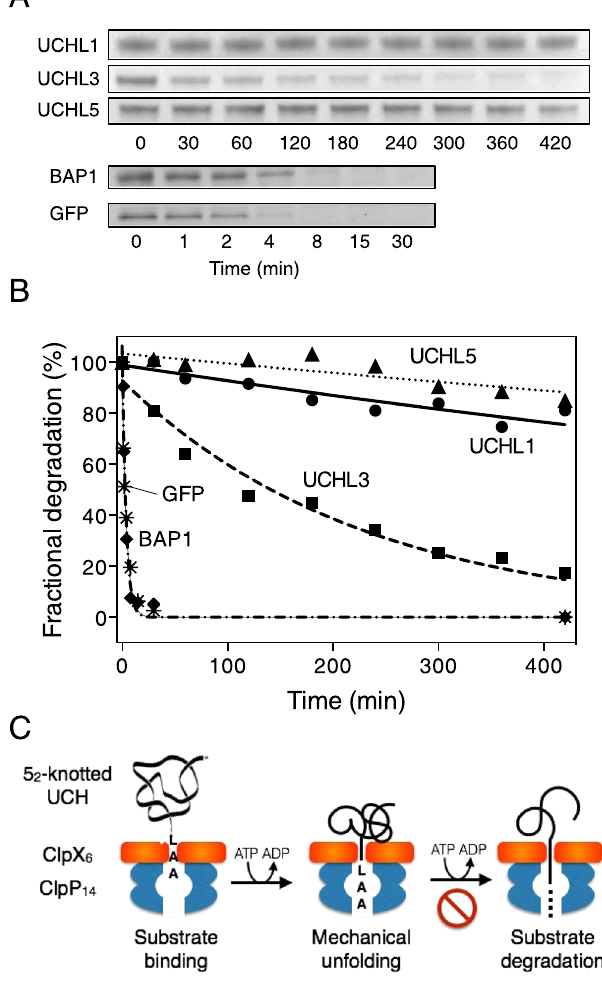
Figure 1. ClpXP-mediated proteolysis of ssrA-tagged UCHs monitored by SDS-PAGE. ( A ) SDS-PAGE images of individual substrates as indicated on the left of each panel. Aliquots were taken at specific time points as indicated below. ( B ) Quantitative image analyses of the results shown in (A) normalized with respect to the initial time point. The results were fit to a single exponential decay function to deduce the apparent life times of individual substrates. The data points represent the mean of three independent degradation assays. ( C ) Schematic presentation of how the knotted UCHs may withstand the mechanical unfolding of ClpXP thereby hindering the subsequent proteolysis.